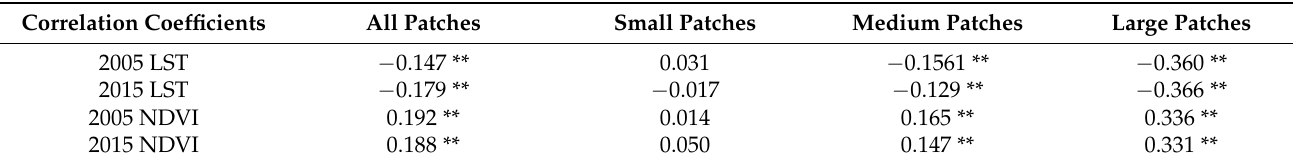
Figure 3. The level of confidence in hot- and coldspots ( a ) in 2006 and ( b ) in 2015. − 3 represents 99% confidence in a coldspot, − 2 represents 95% confidence in a coldspot, − 1 represents 90% confidence in a coldspot, 0 represents no significance, 1 represents 99% confidence in a hotspot, 2 represents 95% confidence in a hotspot, and 3 represents 90% confidence in a hotspot. Table 2. Pearson analysis of LST, NDVI and PA in 2005 and